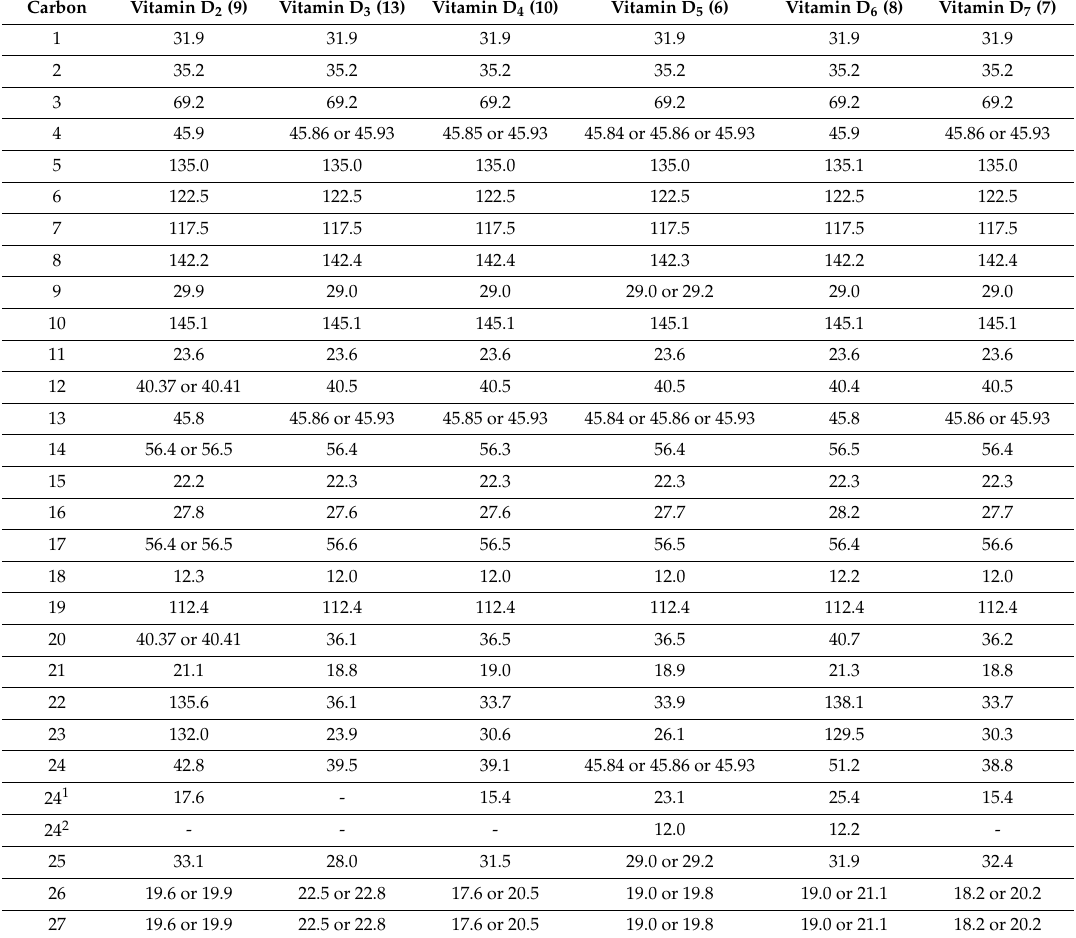
Figure 4. Predicted synthetic pathway of vitamin D 4 ( 10 ). As a result of the synthesis of vitamin D 4 ( 10 ), it believed that 22,23-dihydrobrassicasterol ( 11 ) was contained in the starting compound, commercially available β -sitosterol ( 1 ). Table 1. Carbon-13 chemical shifts ( δ ppm) of the vitamin D